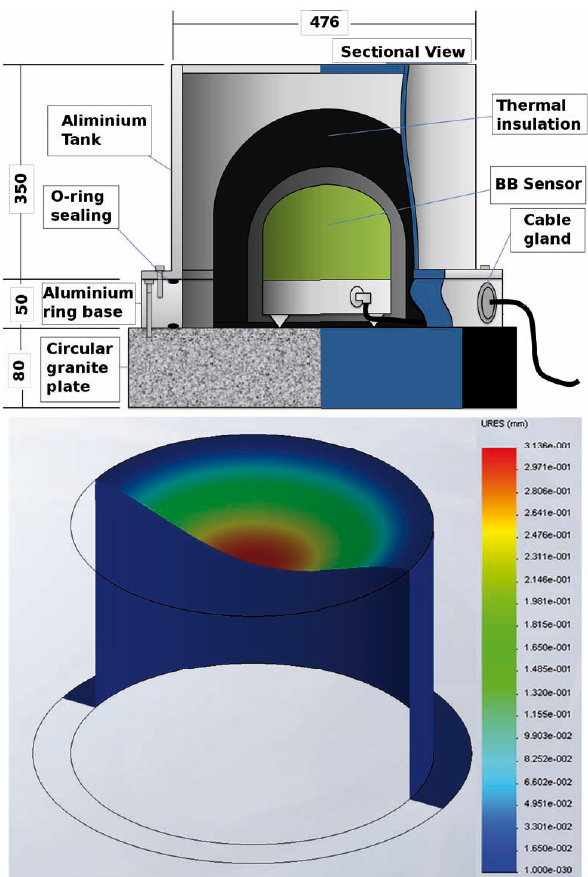
Fig. 5. Effect of a rapid pressure change applied outside the TANK protection